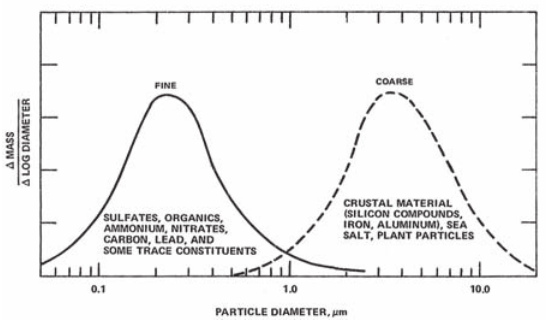
Fig. 2 Fine and Coarse Particle Modes. From U.S. En- vironmental Protection Agency (1982).